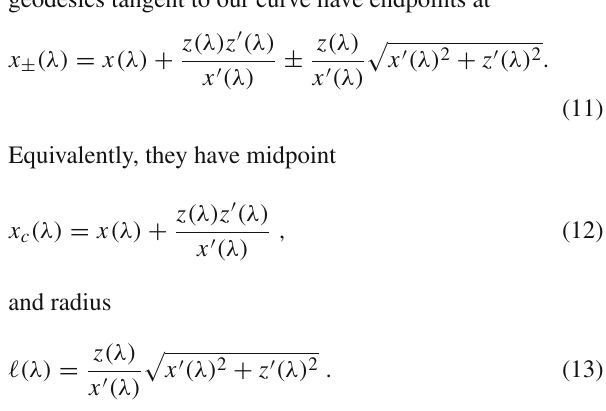
Fig. 3 The blue (purple) curve shows the endpoint x + ( x − ) of the geodesics, as given by (9), for the same example as in Fig. 2. The locations where one or the other endpoint switches sign upon crossing